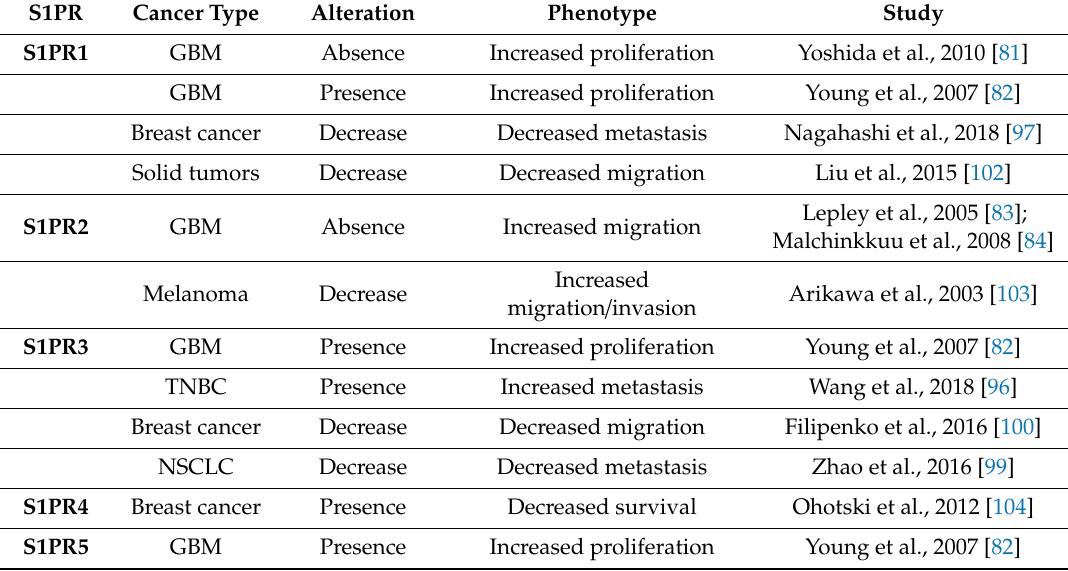
Table 1. Summary of the current research on S1PR e ff ects. S1PRs have multiple e ff ects on cancer cells, illustrating a lack of consensus on the predominant e ff ects in all cancer types. Glioblastoma